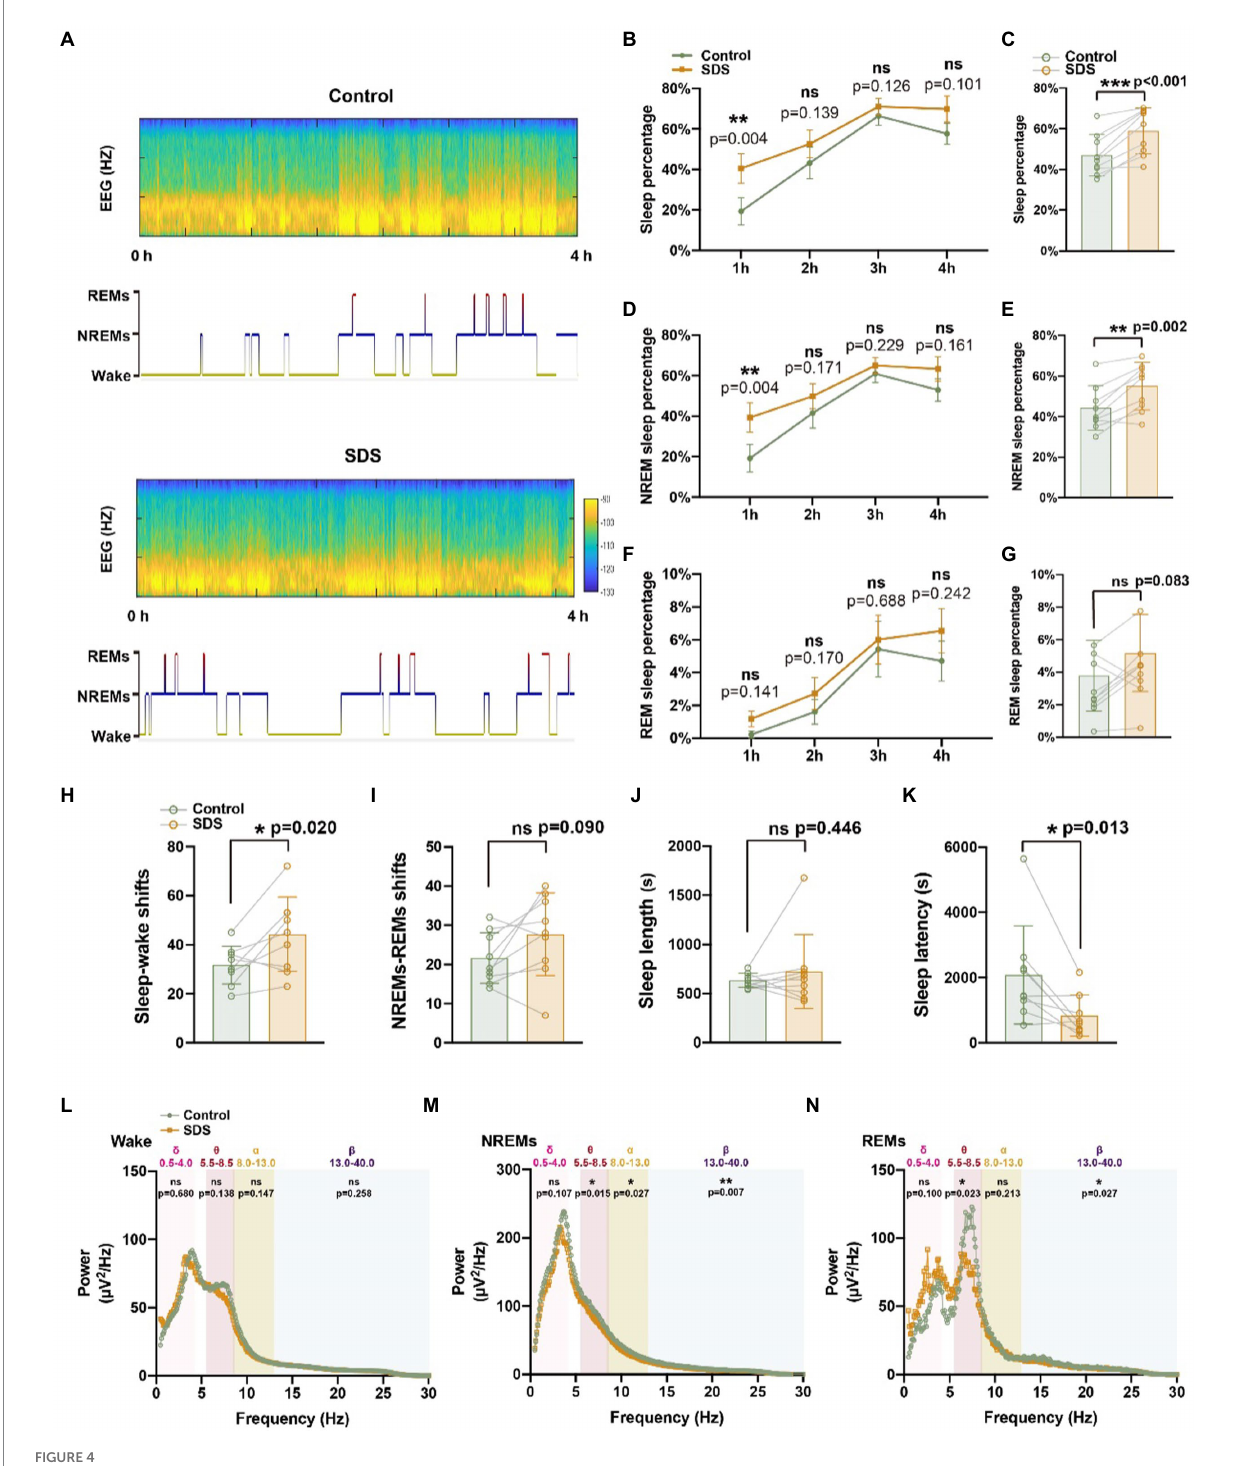
FIGURE 4 SDS promotes sleep in APP/PS1 mice. (A) Representative hypnograms of non-SDS and SDS groups during the 4-h recording. (B–G) Quantitative analysis of the percentage of sleep, NREMs, and REMs in each hour (B,D,F) and in 4 h (C,E,G) . (H–K) Quantitative analysis of sleep–wake shifts, NREMs- REMs shifts, sleep length, and sleep latency in non-SDS and SDS groups during the 4-h recording. (L–N) Spectral plot in wake, NREMs, and REM phases in non-SDS and SDS groups. n = 9, paired t